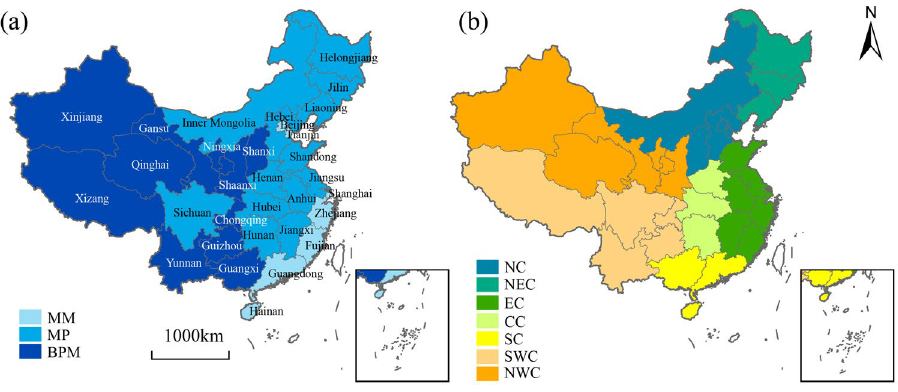
Figure 1. Schematic diagram of division: ( a ) production and marketing sub-regions; ( b ) physical geographic divisions. geographic